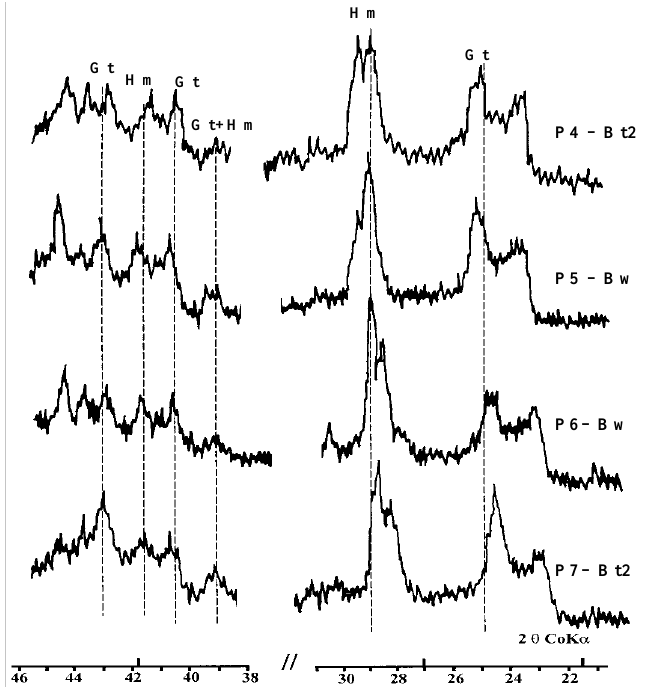
Figura 5. Difratogramas de raio-X da fração argila concentrada com NaOH 5M (não orientada) dos horizontes diagnósticos subsuperficiais dos perfis desenvolvidos de sedimentos da Formação Barreiras (Hm: Hematita e Gt: